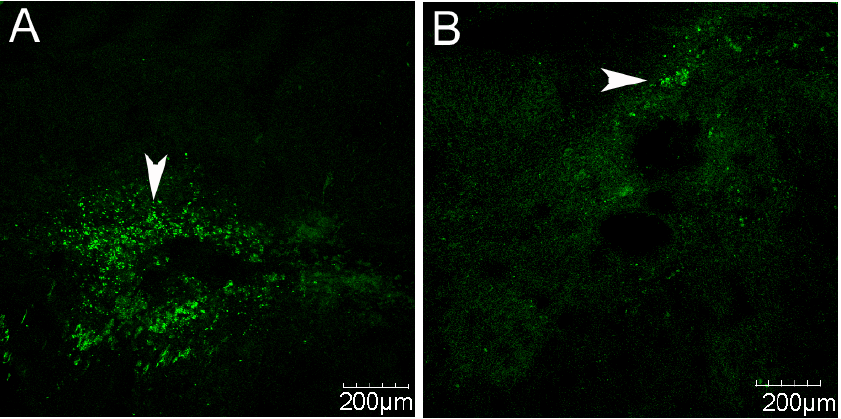
Figure 4. Immunofluores- cence staining for anti- nucleus and mitotic cell antigen (NUMA) ( A , D , G ), glial fibrillary acidic protein (GFAP) ( B ), synaptophysin ( E ), and chondroitin sulfate proteoglycan (NG2) ( H ) in sections of spinal cord at the T9 level of animals transplanted with mononu- clear cells from umbilical cord blood 1 h after the lesion. Overlapping of the antibodies is represented as: C , NUMA (green) and GFAP (red); F , NUMA (green) and synaptophysin (red); I , NUMA (green) and chondroitin sulfate proteo- glycan (NG2) (red). Arrow- heads indicate: NUMA-pos- itive cells ( A , D , G ); positive cells when labeled with GFAP ( B ), synaptophysin ( E ), and NG2 ( H ); double- labeling with NUMA and GFAP ( C ), synaptophysin ( F ), and NG2 ( I ).